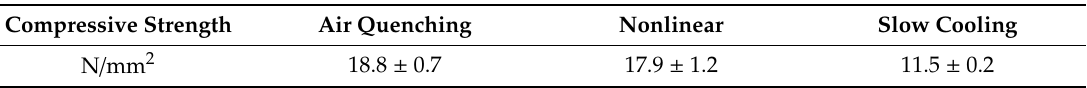
Table 5. Compressive strength (at 7 days) of cement made from clinkers exposed to varying cooling regimes.